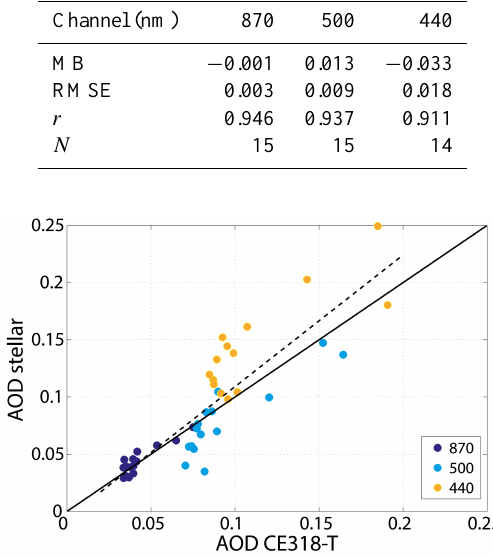
Table 5. Statistics of the CE318-T and star photometer AOD com- parison during August 2014: mean bias (MB), root mean square error (RMSE), Pearson correlation coefficient ( r ) and number of coincidences ( N ).